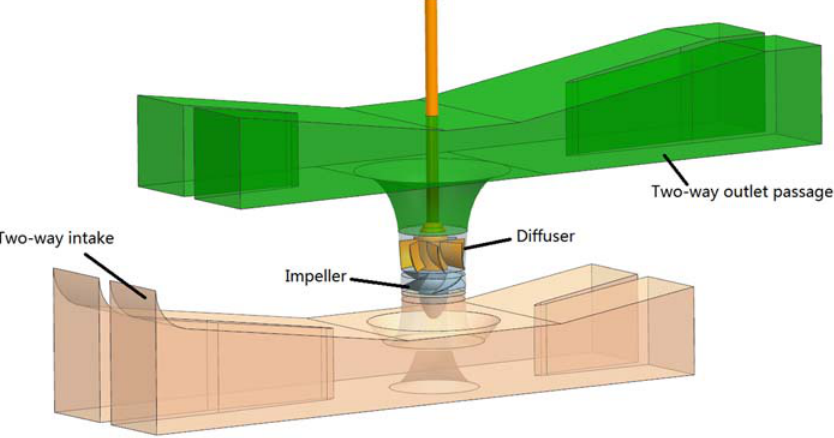
Figure 2. Three ‐ dimensional perspective view of the model pump unit.